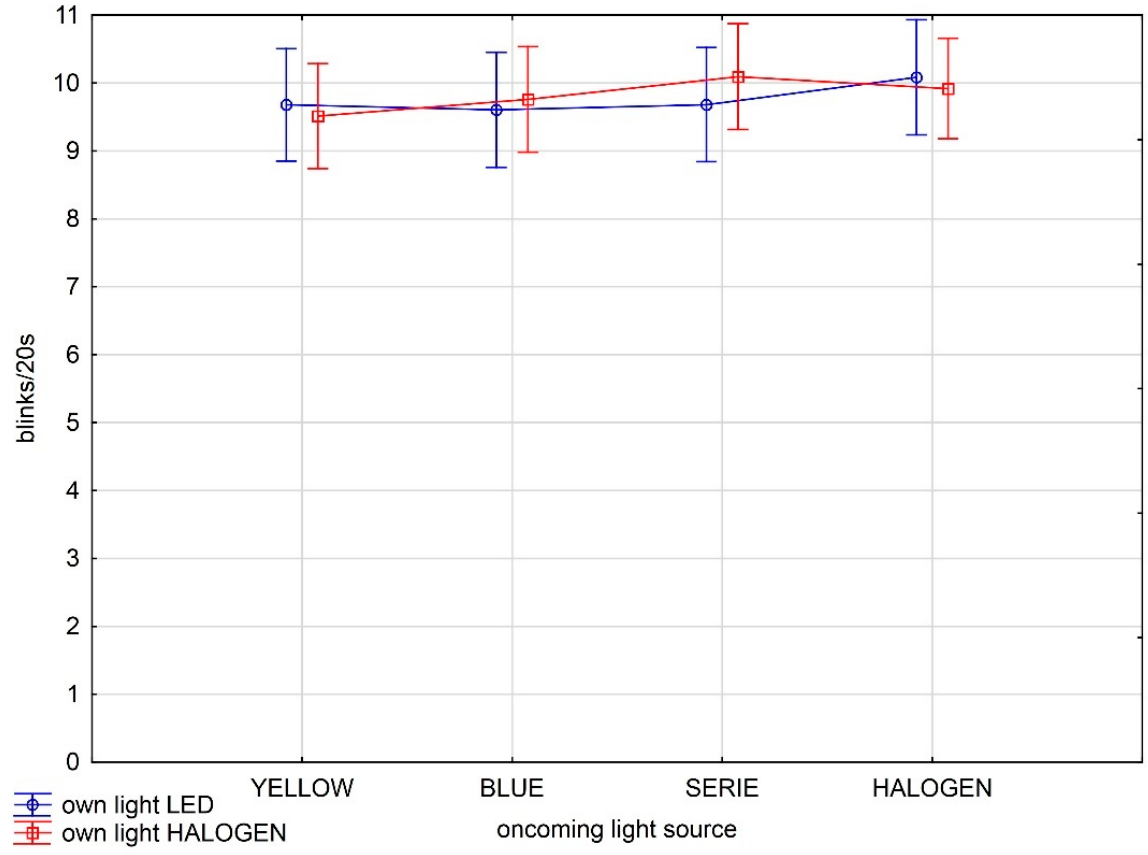
Figure 5. Relationship between eye-blinking frequency and the combination of driver’s and oncoming traffic headlights.